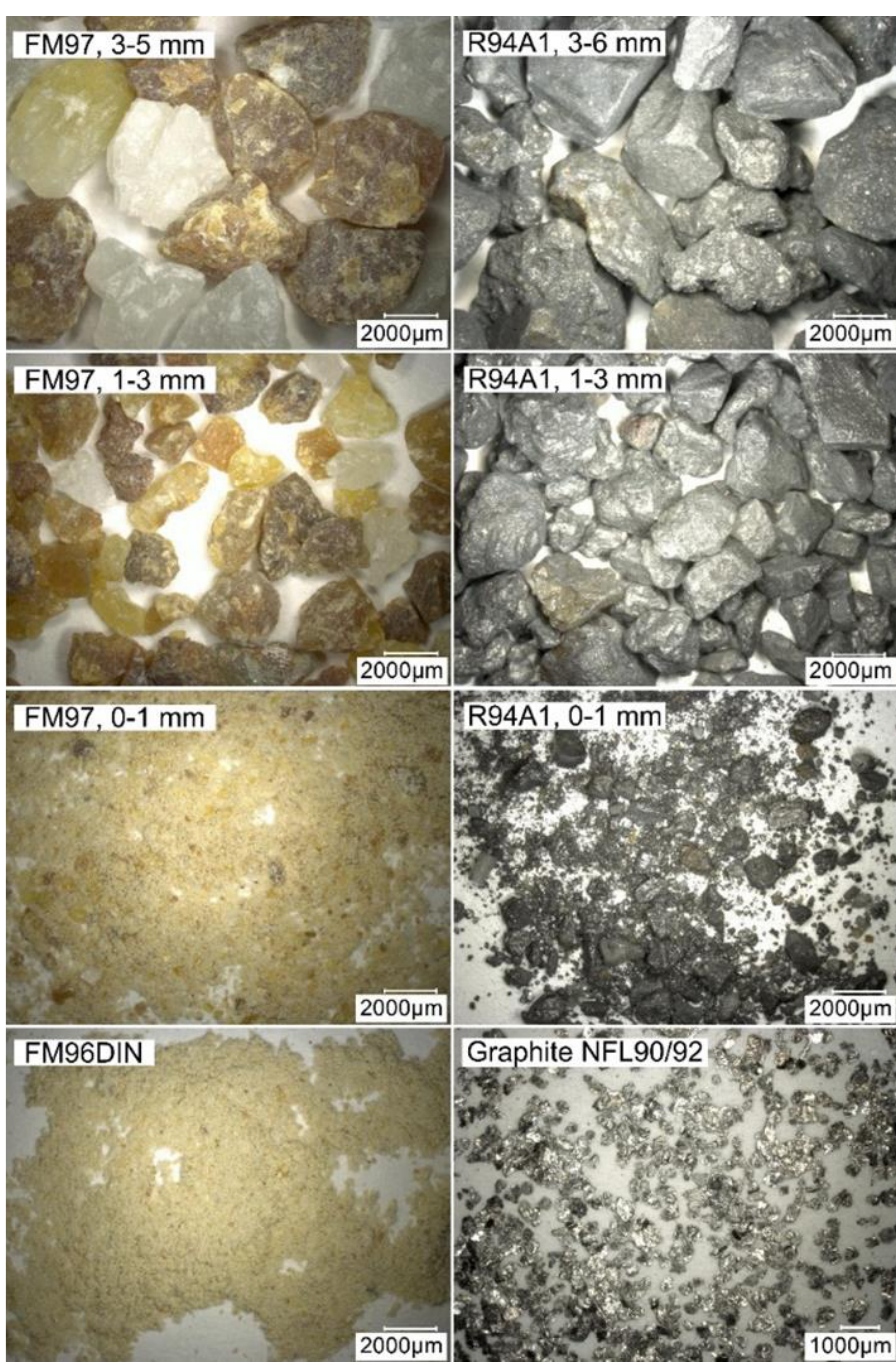
Figure 1. Raw materials used.